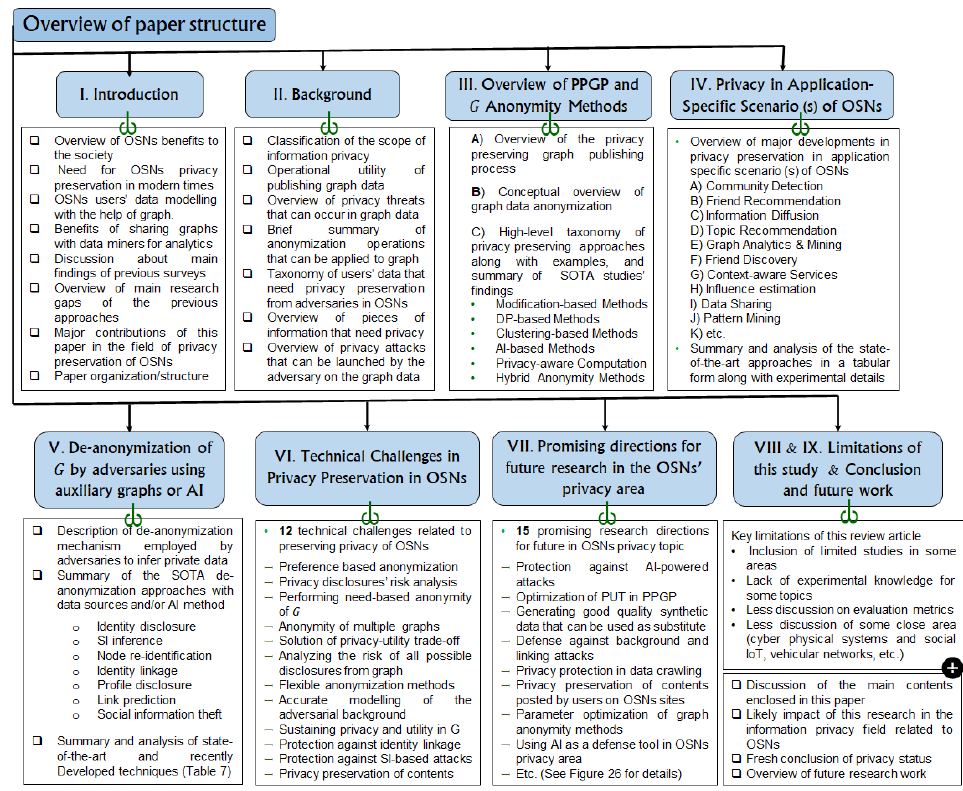
Figure 3. Comprehensive overview of the structure of this review